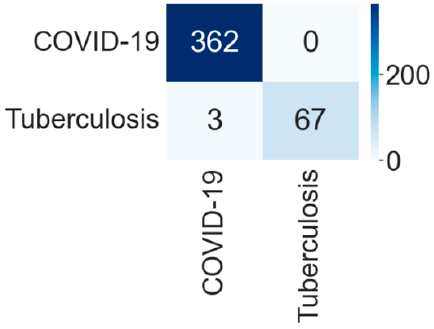
Figure 15. Confusion matrix for the classification into COVID-19 and tuberculosis by VGG16.